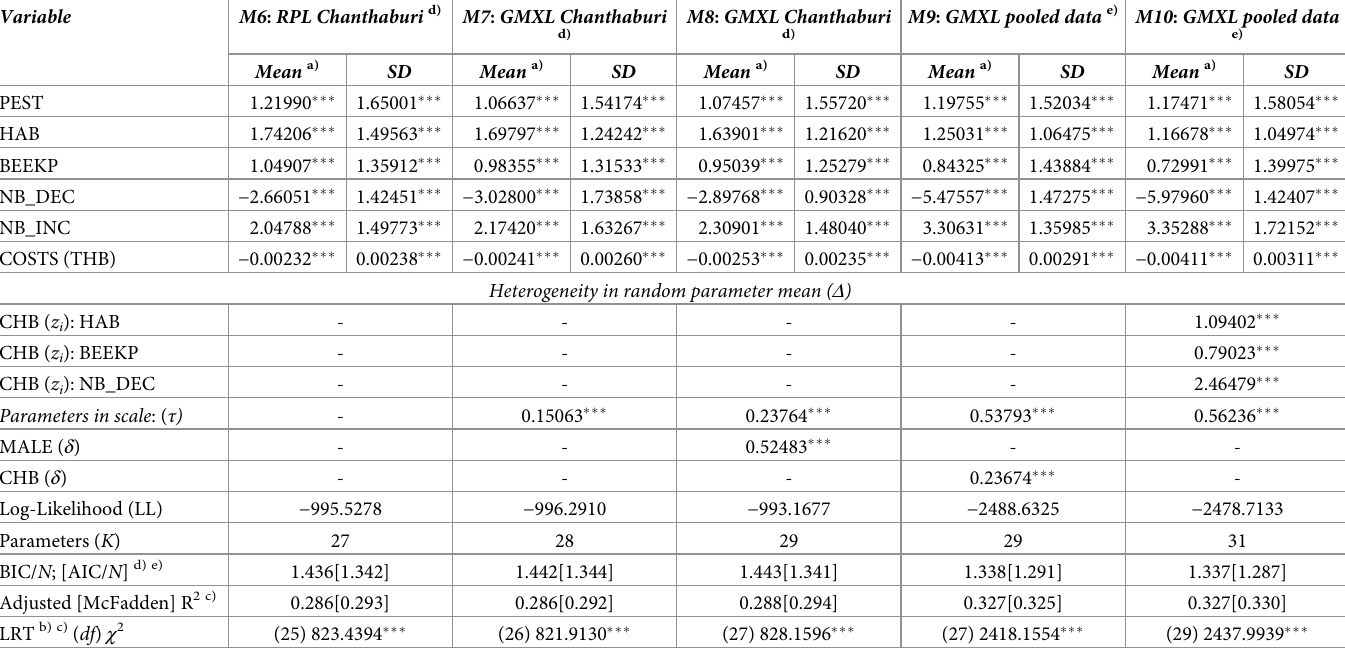
Table 4. Random parameter logit (RPL) and generalized mixed logit (GMXL; γ fixed at 1) models fitted on Chanthaburi dataset and GMXL fitted on pooled data. Variable M6 : RPL Chanthaburi d) M7 : GMXL Chanthaburi